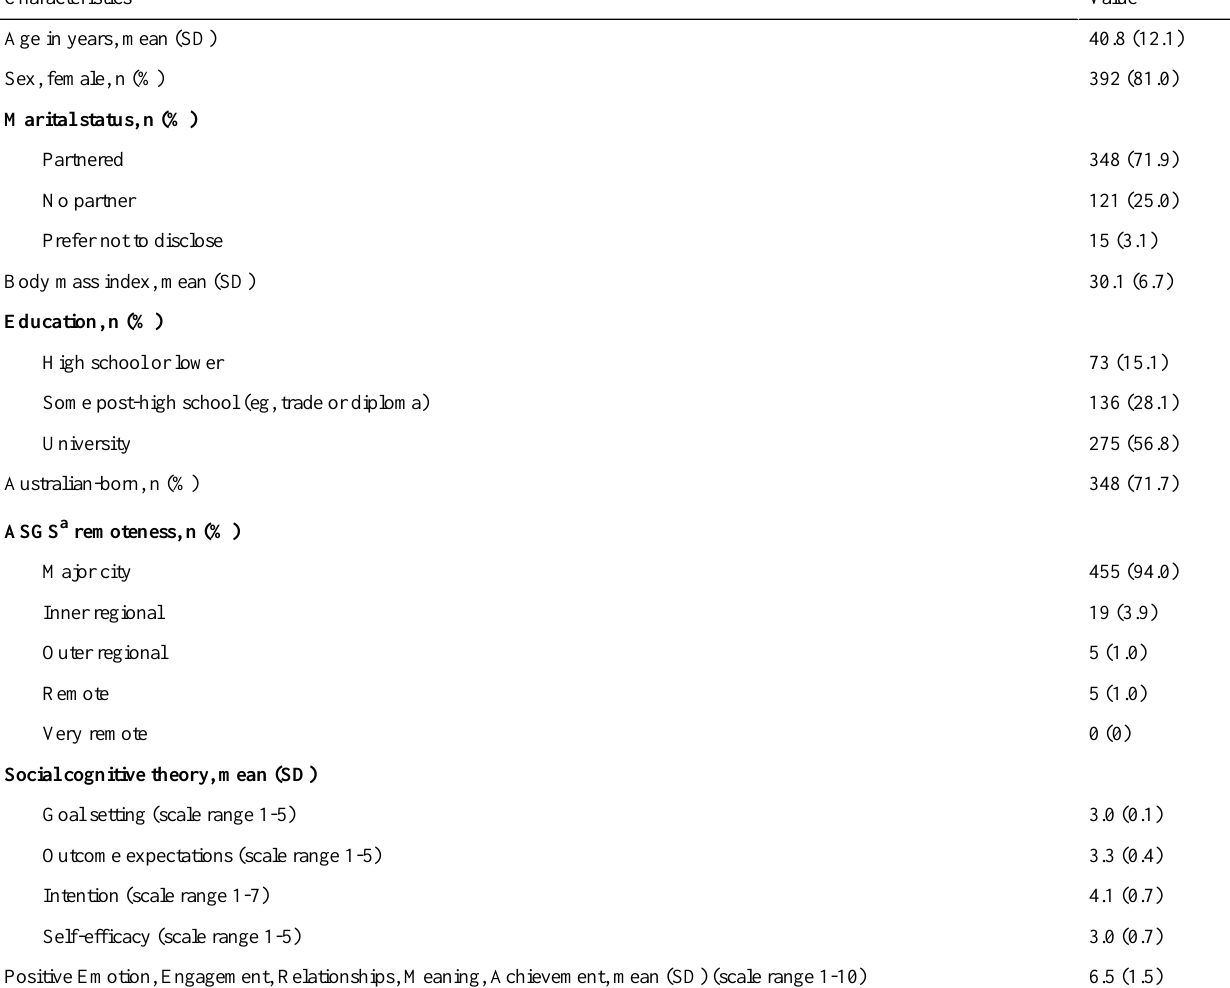
Table 1. Descriptive characteristics of the study sample